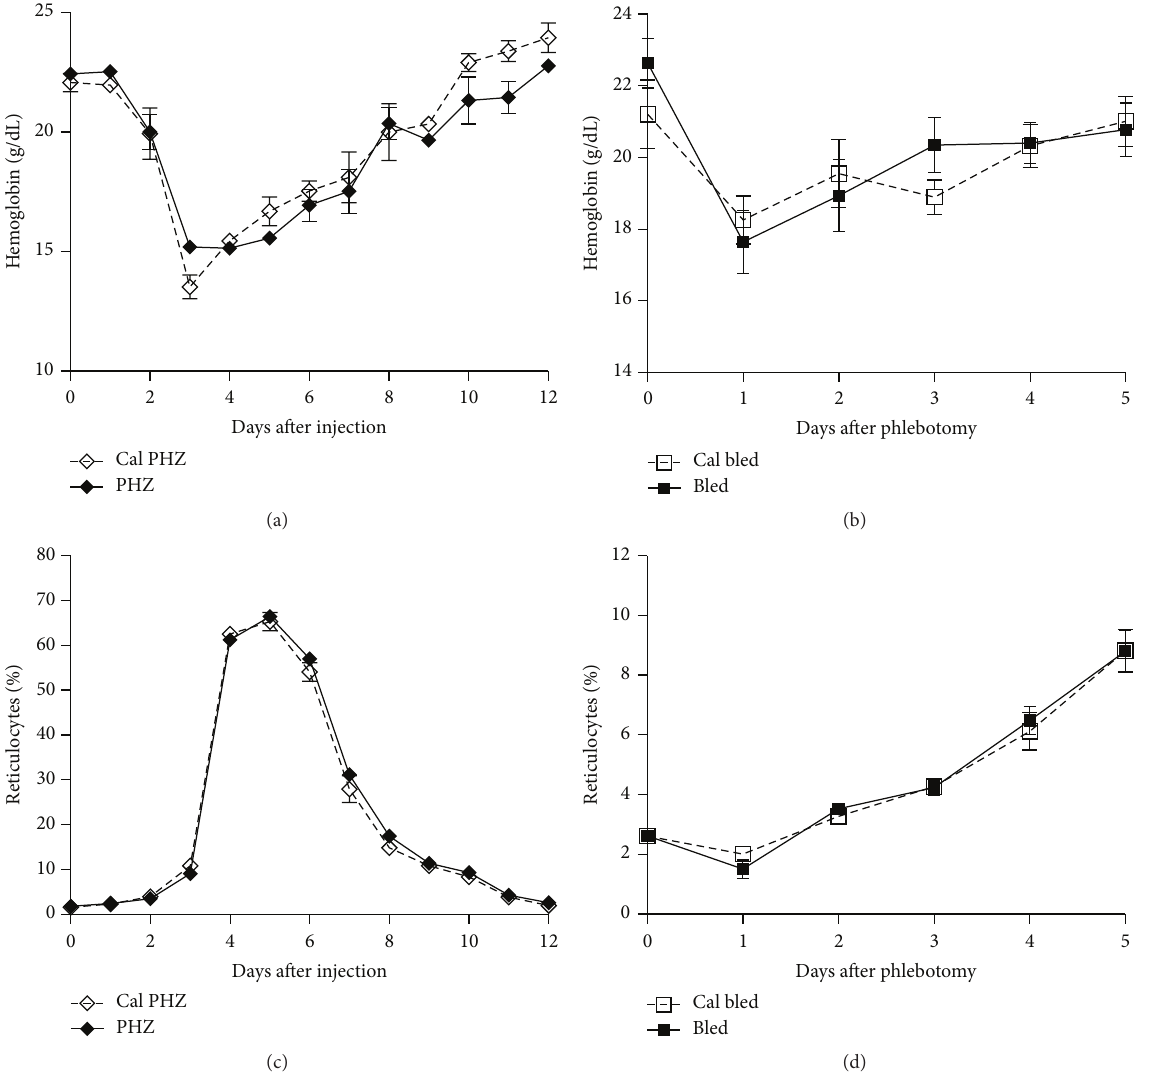
Figure 2: Effect of calcitonin on postexperimental anemia recovery. Mice were treated with calcitonin (Cal-Bled and Cal-PHZ) or PBS (Bled and PHZ) during 5 consecutive days. On the 3rd day of treatment, mice were phlebotomized (Bled and Cal-Bled; 𝑛 = 11 ) or received phenylhydrazine injections (PHZ and Cal-PHZ; 𝑛 = 3 ) and blood hemoglobin concentration (a and b) and reticulocytosis (c and d) were monitored daily. Data are mean ± SEM and values are compared using a nonparametric Student’s 𝑡